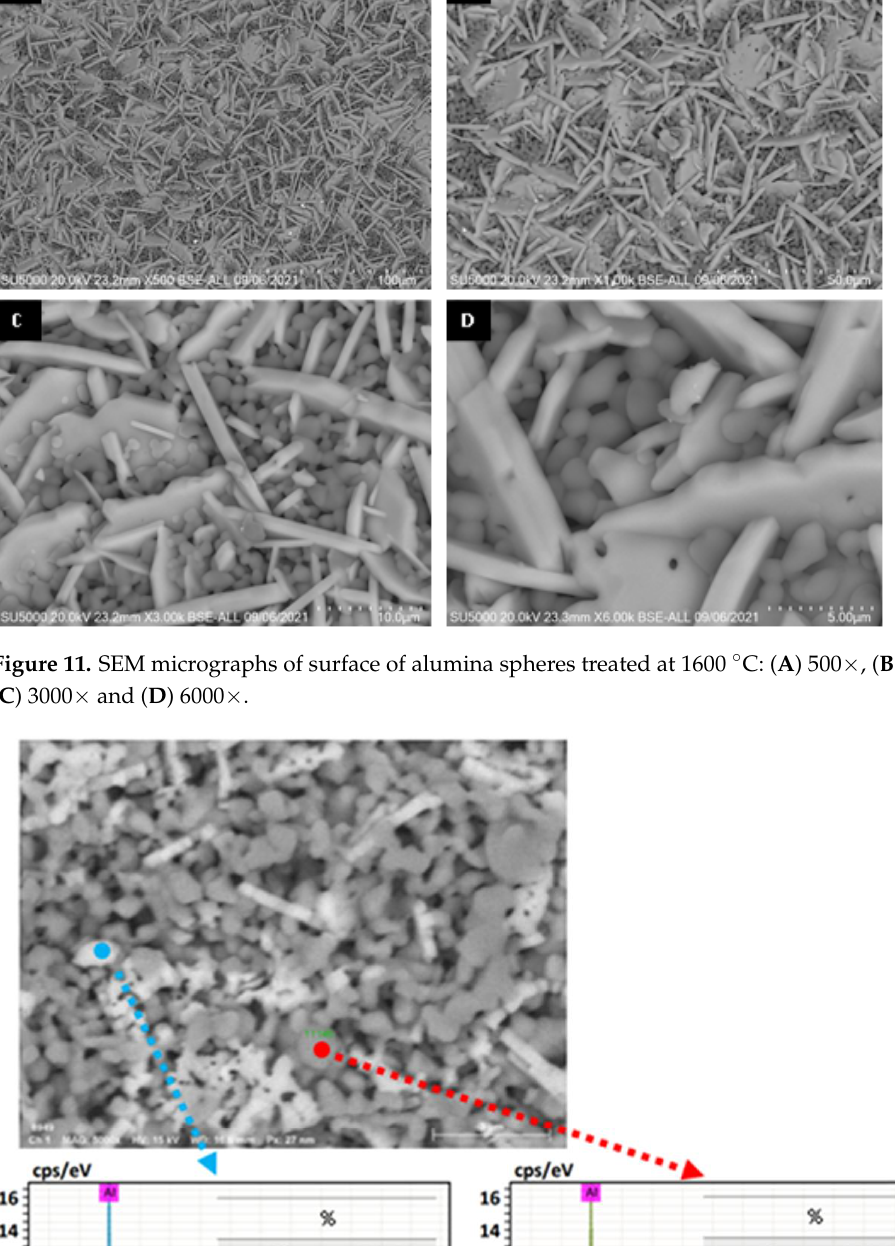
Figure 10. SEM micrographs of non-fragmented ( A – C ) and fragmented ( D – F ) alumina spheres treated at 1600 °C.